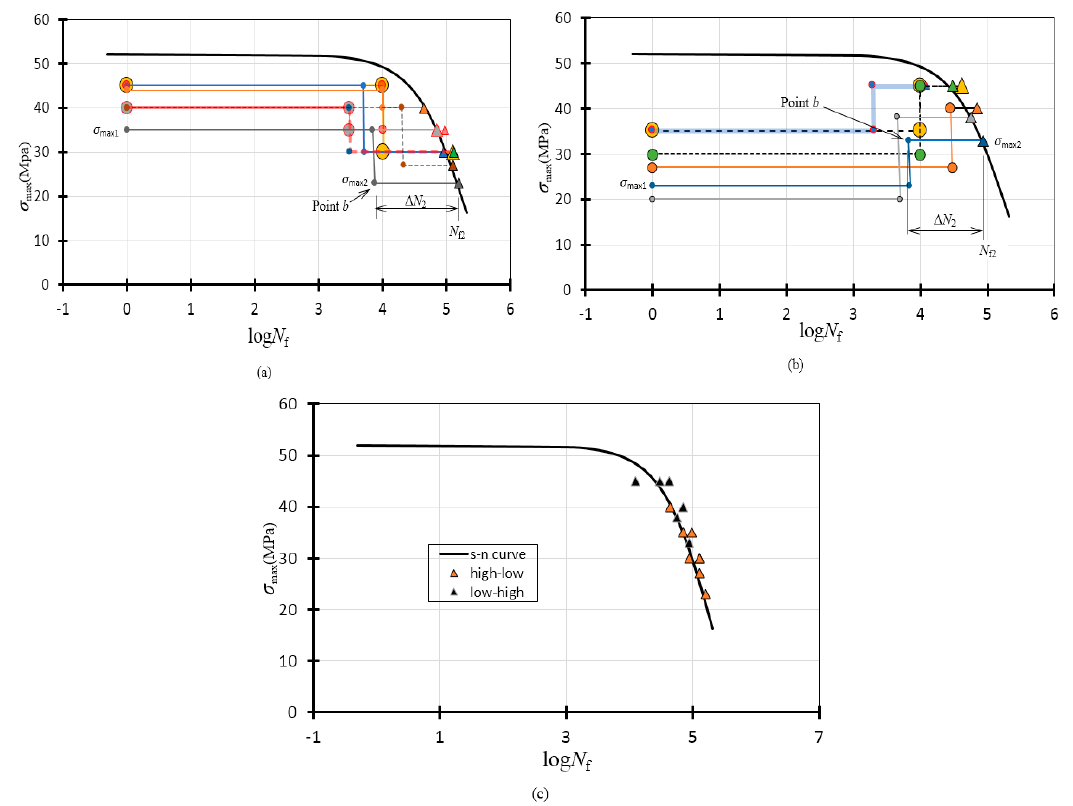
Figure 10. Remaining fatigue life prediction represented by an S-N curve and experimental data points represented by triangular data points: ( a ) high-low loading paths; ( b ) low-high loading paths; and ( c ) combined experimental results. Table 1. High-low fatigue loading for remaining fatigue life.